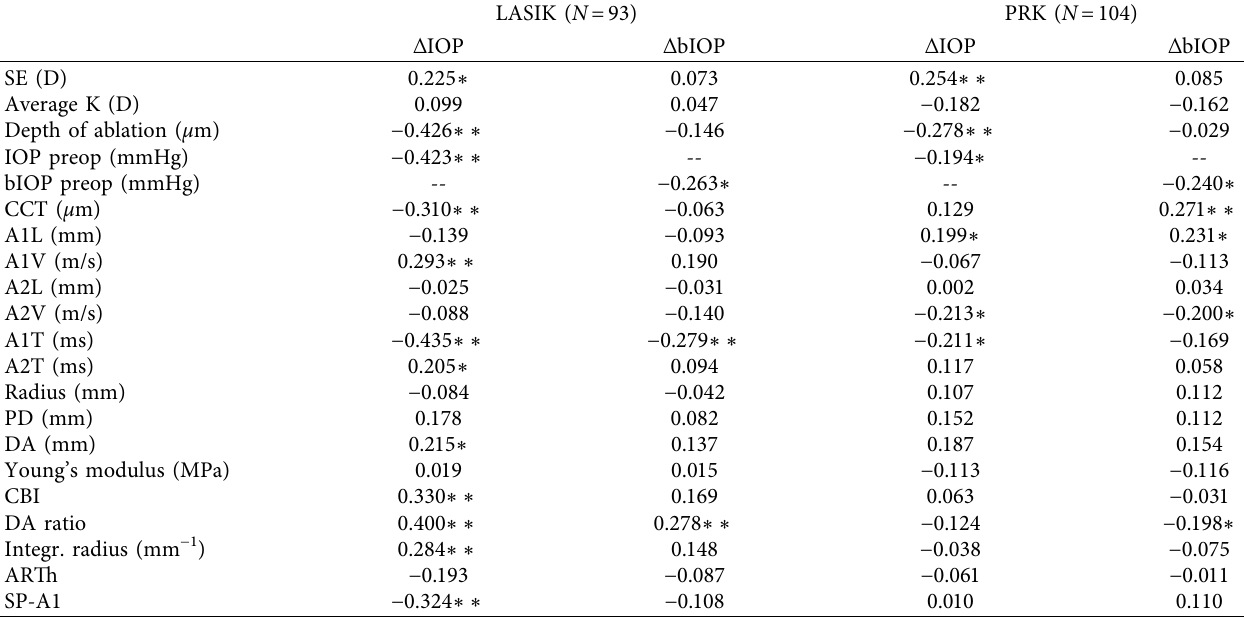
Table 2: Potential factors associated with changes in IOP and bIOP after FS-LASIK and